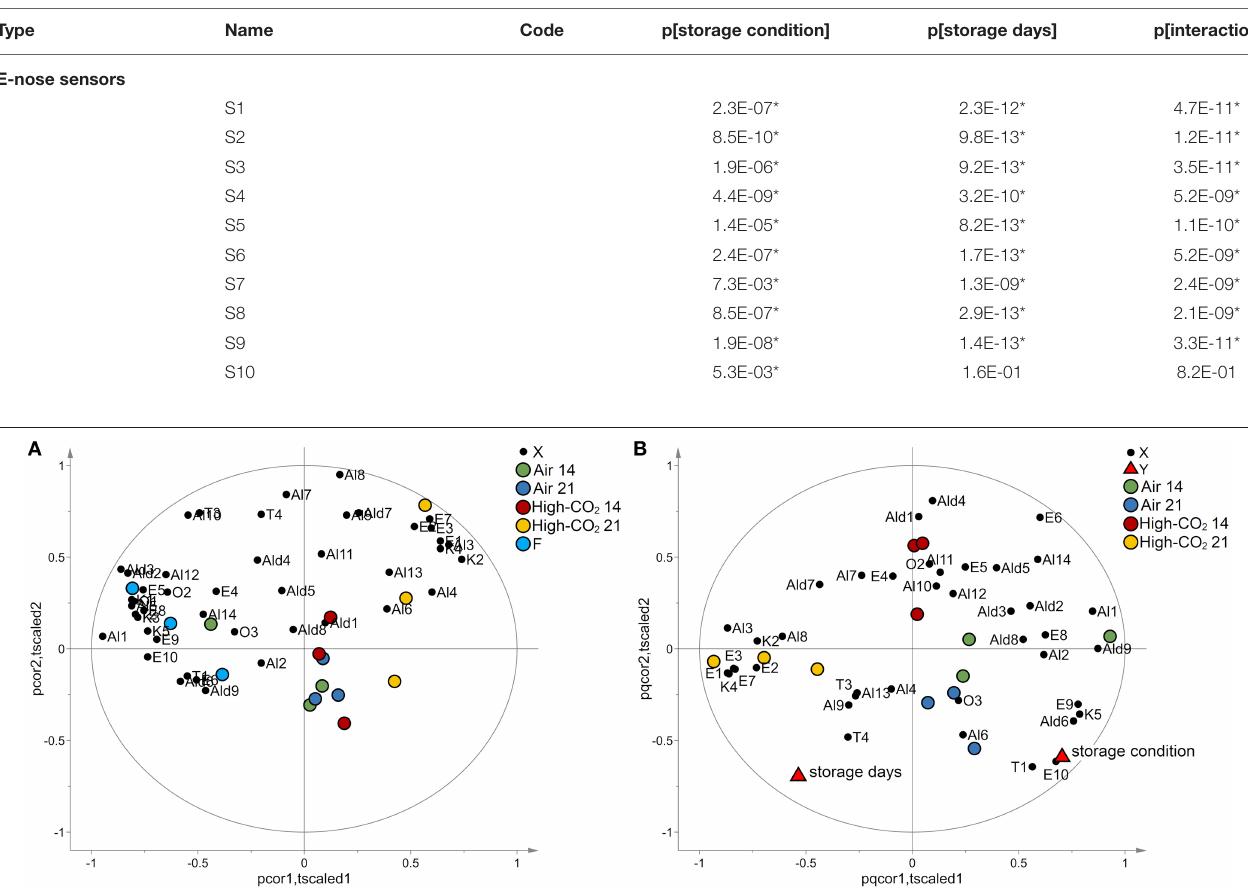
FIGURE 4 | VOCs data. In (A) , the biplot generated by PCA is reported. The points representing the VOCs (black circles) are reported in the same plot of the points representing the samples of sweet cherry cv “Ferrovia.” Fresh fruits (light blue circles) and samples packed in high-CO 2 for 21 days (yellow circles) are evidently separated from the other samples. When VOCs and points representing samples are close, VOCs show high levels for those samples or if their images obtained by inversion in the origin are close to the points representing the samples, low levels. In (B) , the biplot obtained by PLS analysis is reported. The points representing the VOCs (black circles), the points representing the responses “storage days” and “storage condition” (red triangles), and the points representing the samples are reported in the same plot. Samples with the same storage days and storage conditions are represented by points close together in the plot. Moreover, responses and VOCs positively correlated are represented by points close to each other while if they are inversely correlated, the points are